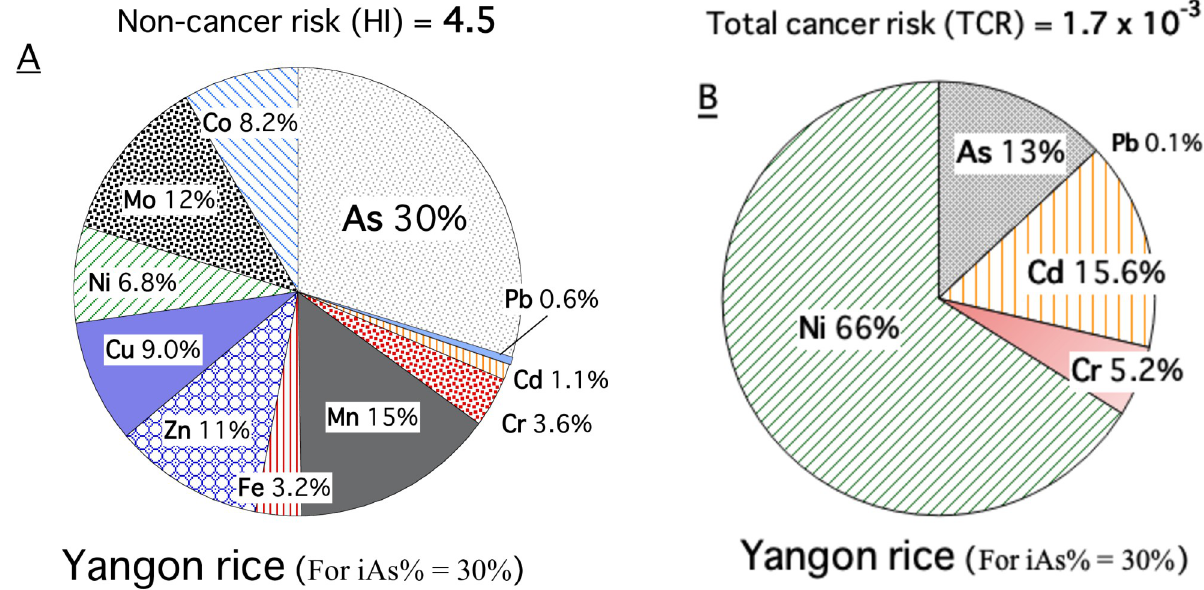
Fig 6. Contribution of individual elements to total health risks for Yangon rice consumers. A) HI represents the sum of each heavy metal’s HQ (non-cancer hazard quotient) values. “HQ = 1” indicates that the level of exposure is likely to cause non-carcinogenic diseases. B) TCR represents total cancer risks, the sum of each heavy metal’s CR (cancer risk) values for exposure duration (26 years). A TCR = 10 − 6 to 10 − 4 indicates that the level of exposure is likely to cause carcinogenic